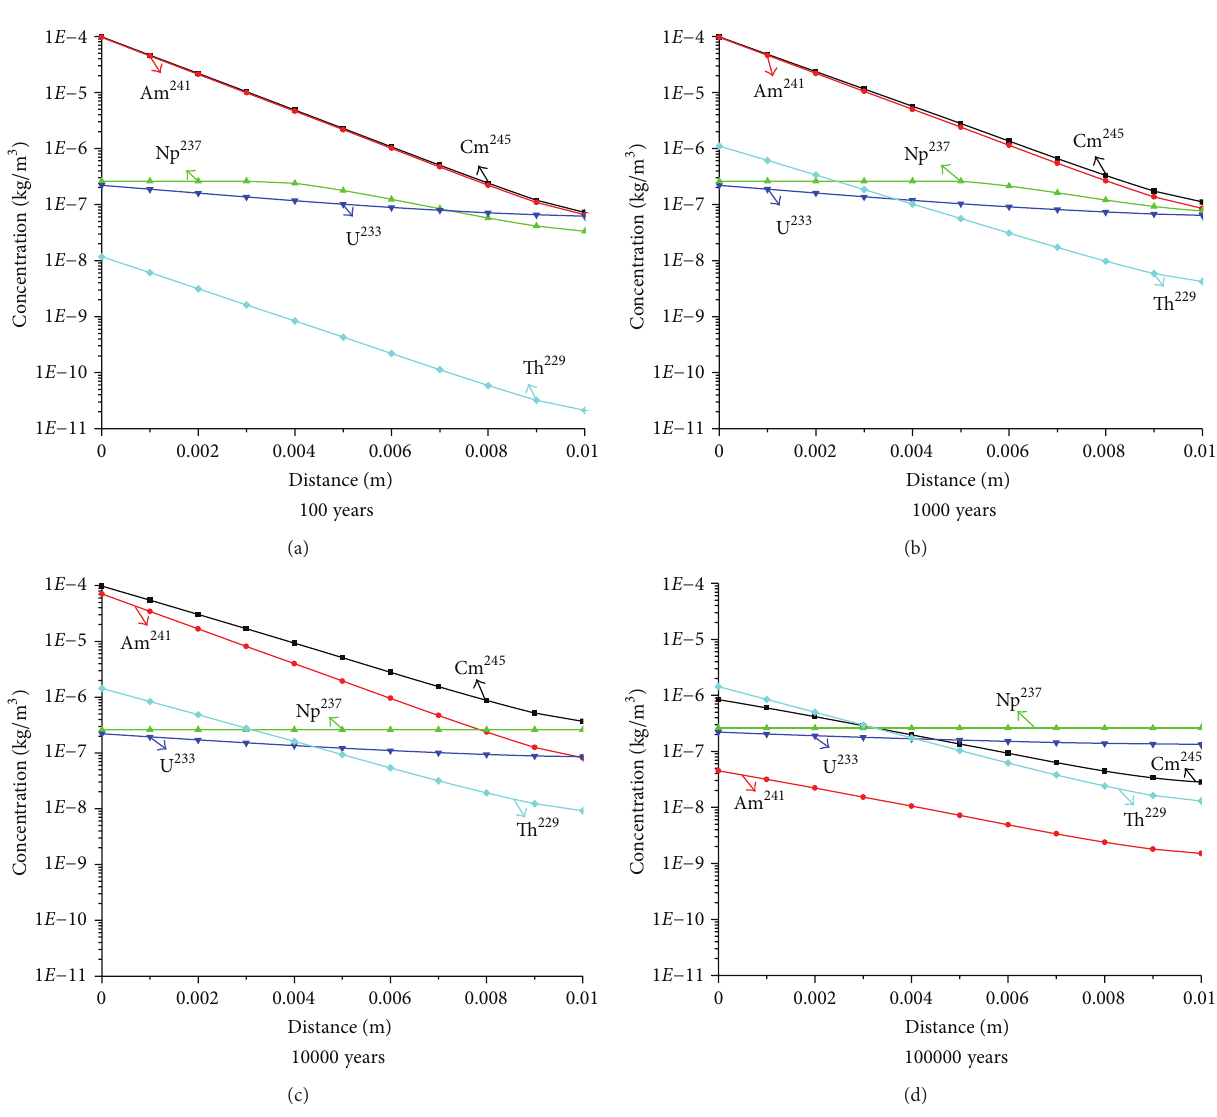
Figure 8: Concentration profiles in extruded bentonite region, for nuclides of 4 𝑛 + 1 chain (Cm 245 → Am 241 → Np 237 → U 233 → Th 229 ) for 10 2 , 10 3 , 10 4 , and 10 5